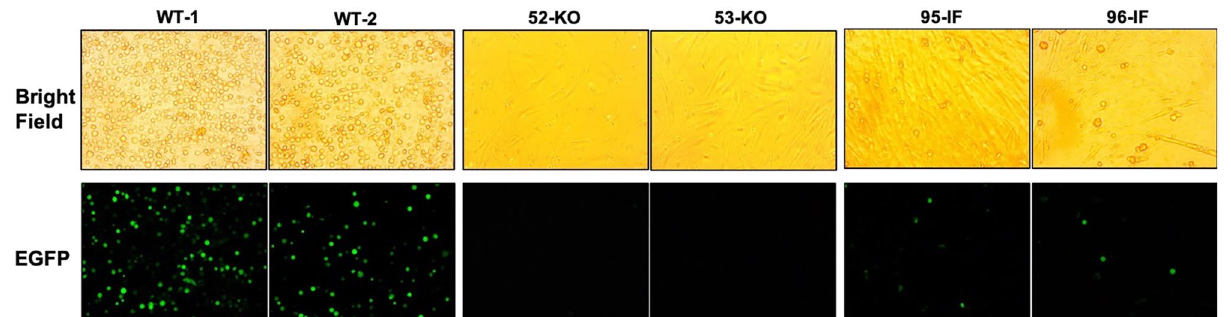
Figure 6. Infection of WT, KO, and IF cells with SVA-EGFP. Photomicrographs taken 8 h after infection of fibroblast cells with SVA isolate, KS15-01-EGFP, at the same exposure. KO cells were from the two pigs of the first SVA challenge, and IF cells were from two pigs of the second SVA